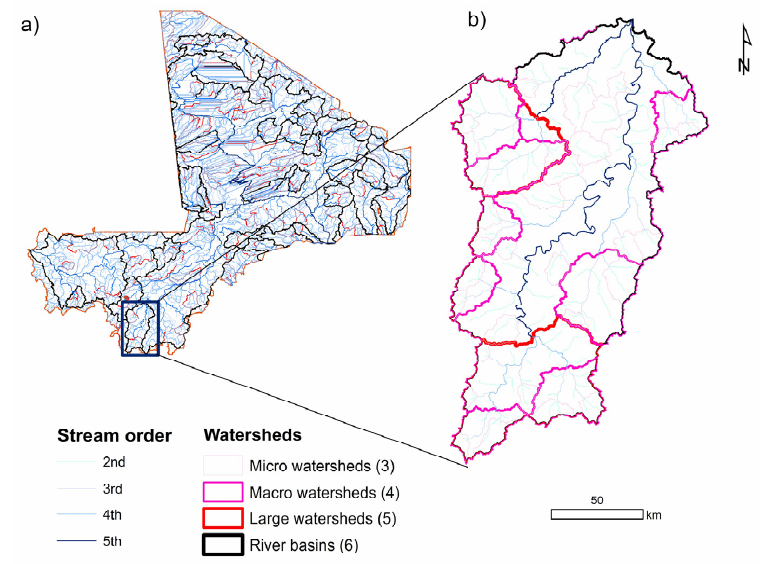
Figure 3. Fourth order watersheds in Mali derived using SRTM data: ( a ) fourth order watersheds for whole Mali; and ( b ) stream order network for selected area.